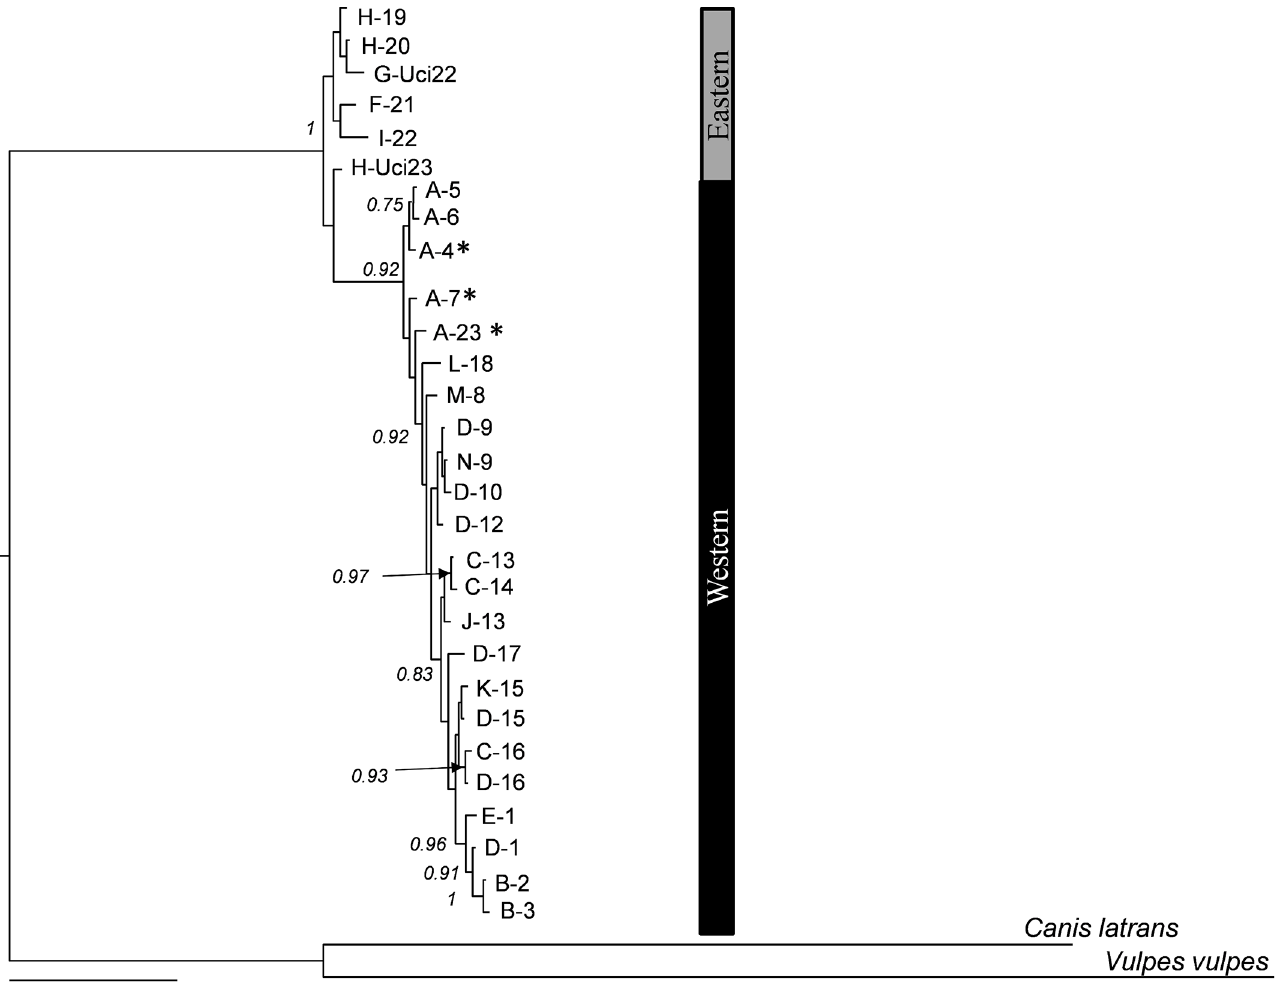
Fig 3. Bayesian phylogeny of concatenated 785 bp cytochrome b and D loop haplotypes. Tree was constructed using HKY (cytochrome b ) and HKY+ Γ (D loop) models of DNA substitution. Bayesian posterior probability values > 0.75 are shown at nodes. Asterisks denote haplotypes of island foxes.